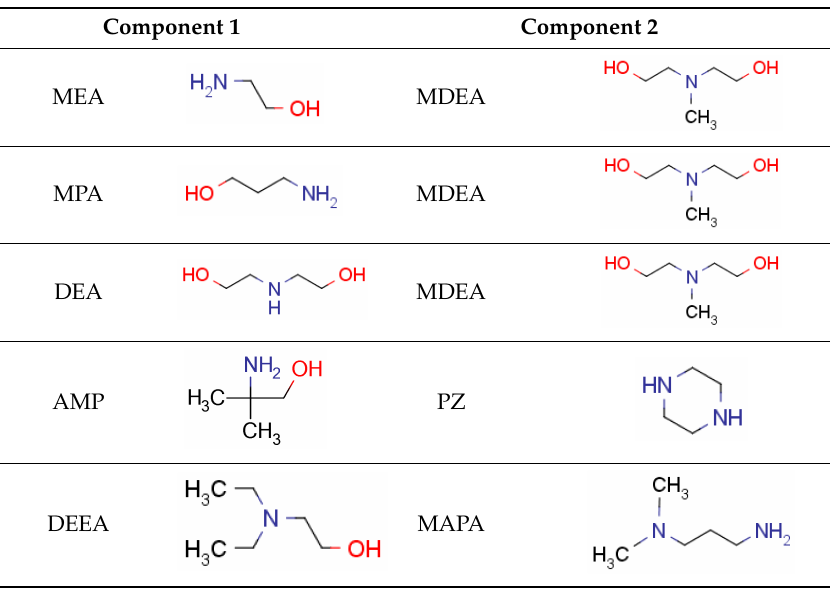
Table3. Mixturesemployedinthiswork. 2-(Diethylamino)ethanol(DEEA) /